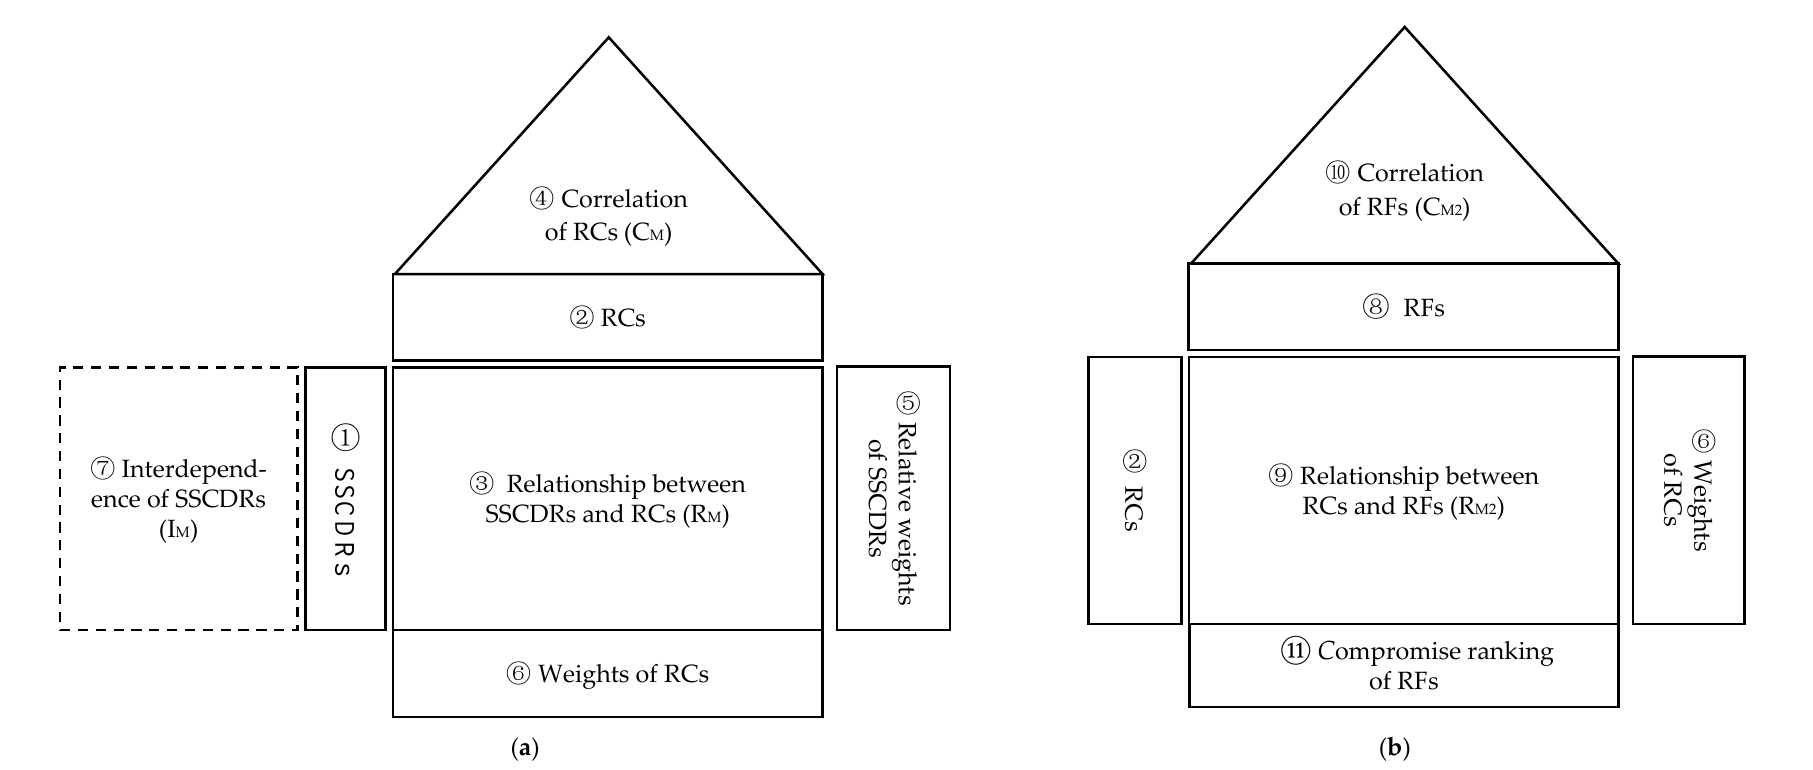
Figure 3. Structure of the two-phase houses of quality (HoQs). ( a ) First HoQ; ( b ) Second HoQ.